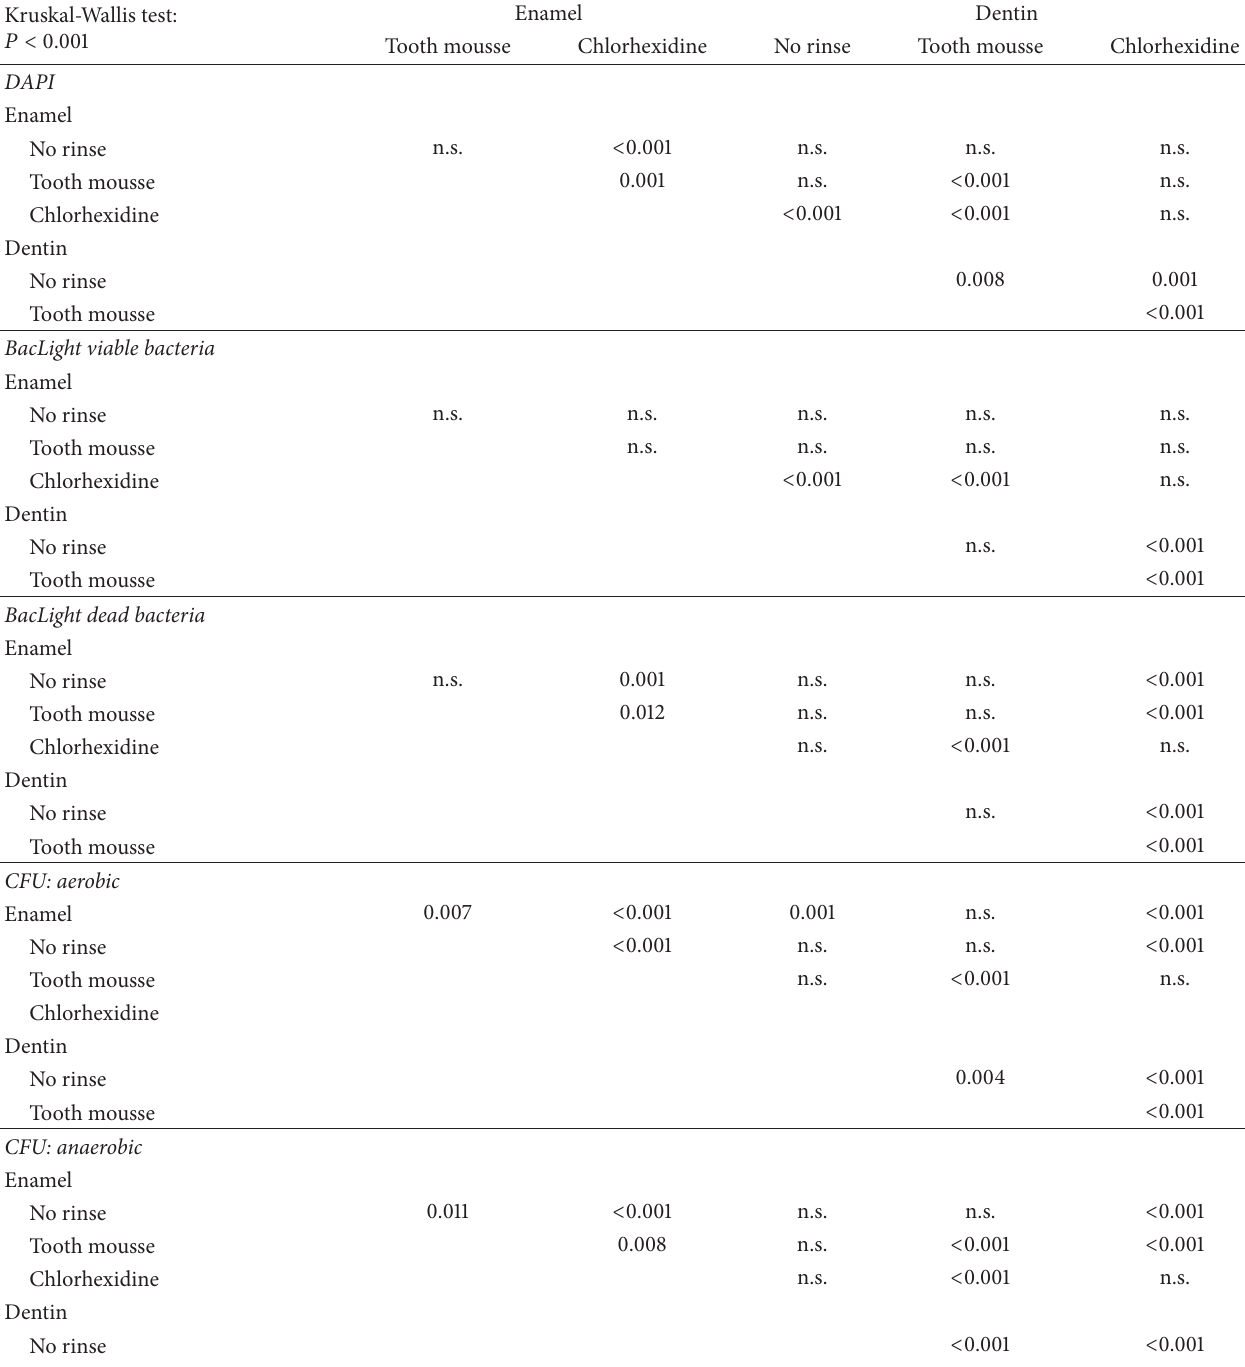
Table 1: Statistical evaluation of the in situ experiments with the different preparations; Kruskal-Wallis test and additional pairwise comparison with Mann-Whitney 𝑈 test ( 𝑃 <